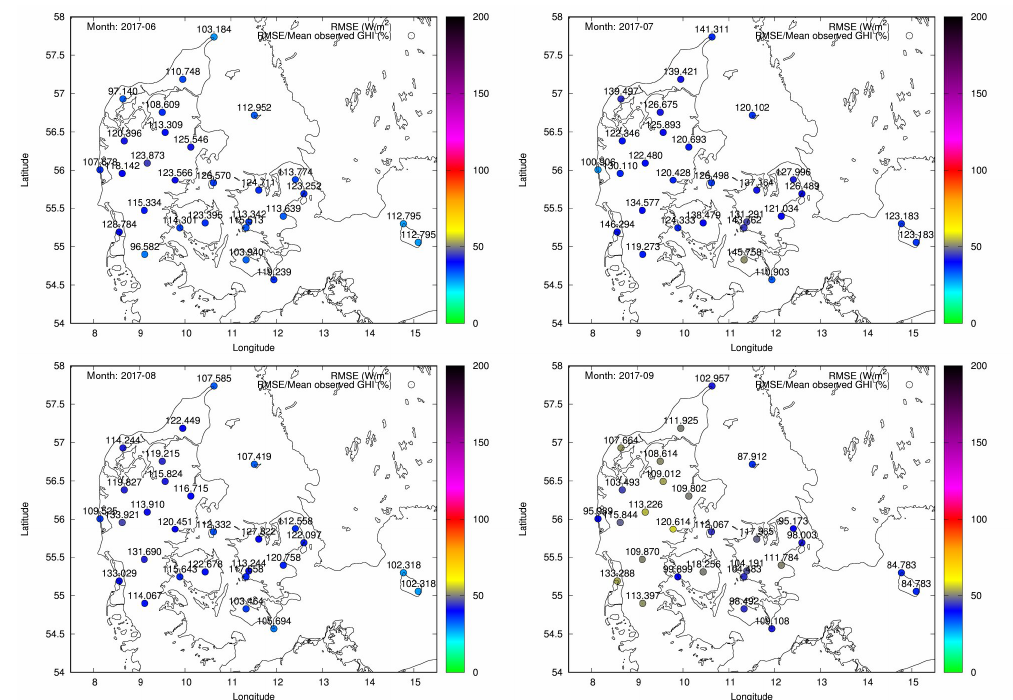
Figure 8. Monthly mean RMSE per station in Denmark for the months of June, July, August and September in 2017. The colour shows the relative RMSE with respect to the measured GHI.